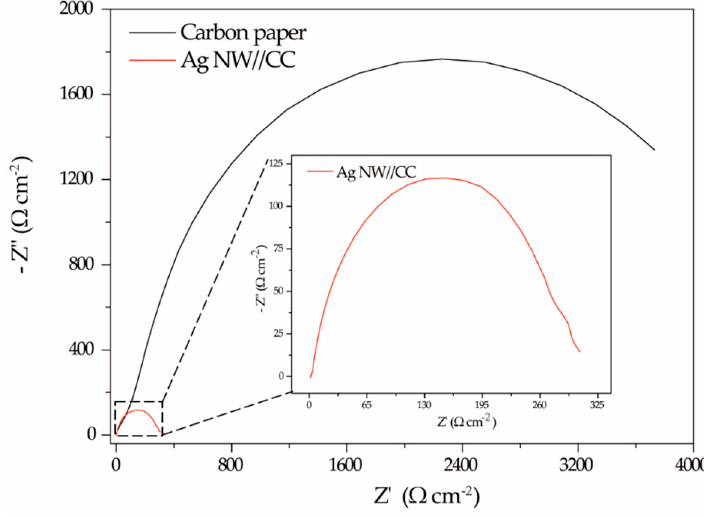
Figure 5. Electrochemical impedance spectroscopy (EIS) curves of pristine CC and Ag NW//CC electrodes. Inset is the magnified EIS curve of the Ag NW//CC electrode.